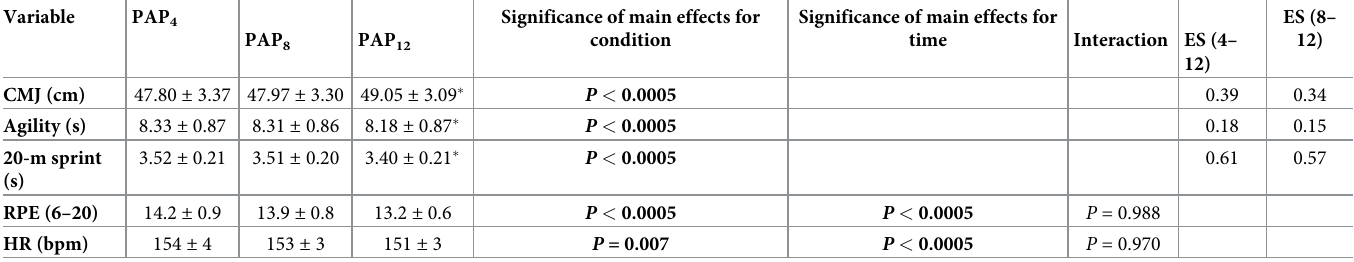
� Denotes a significant difference with PAP